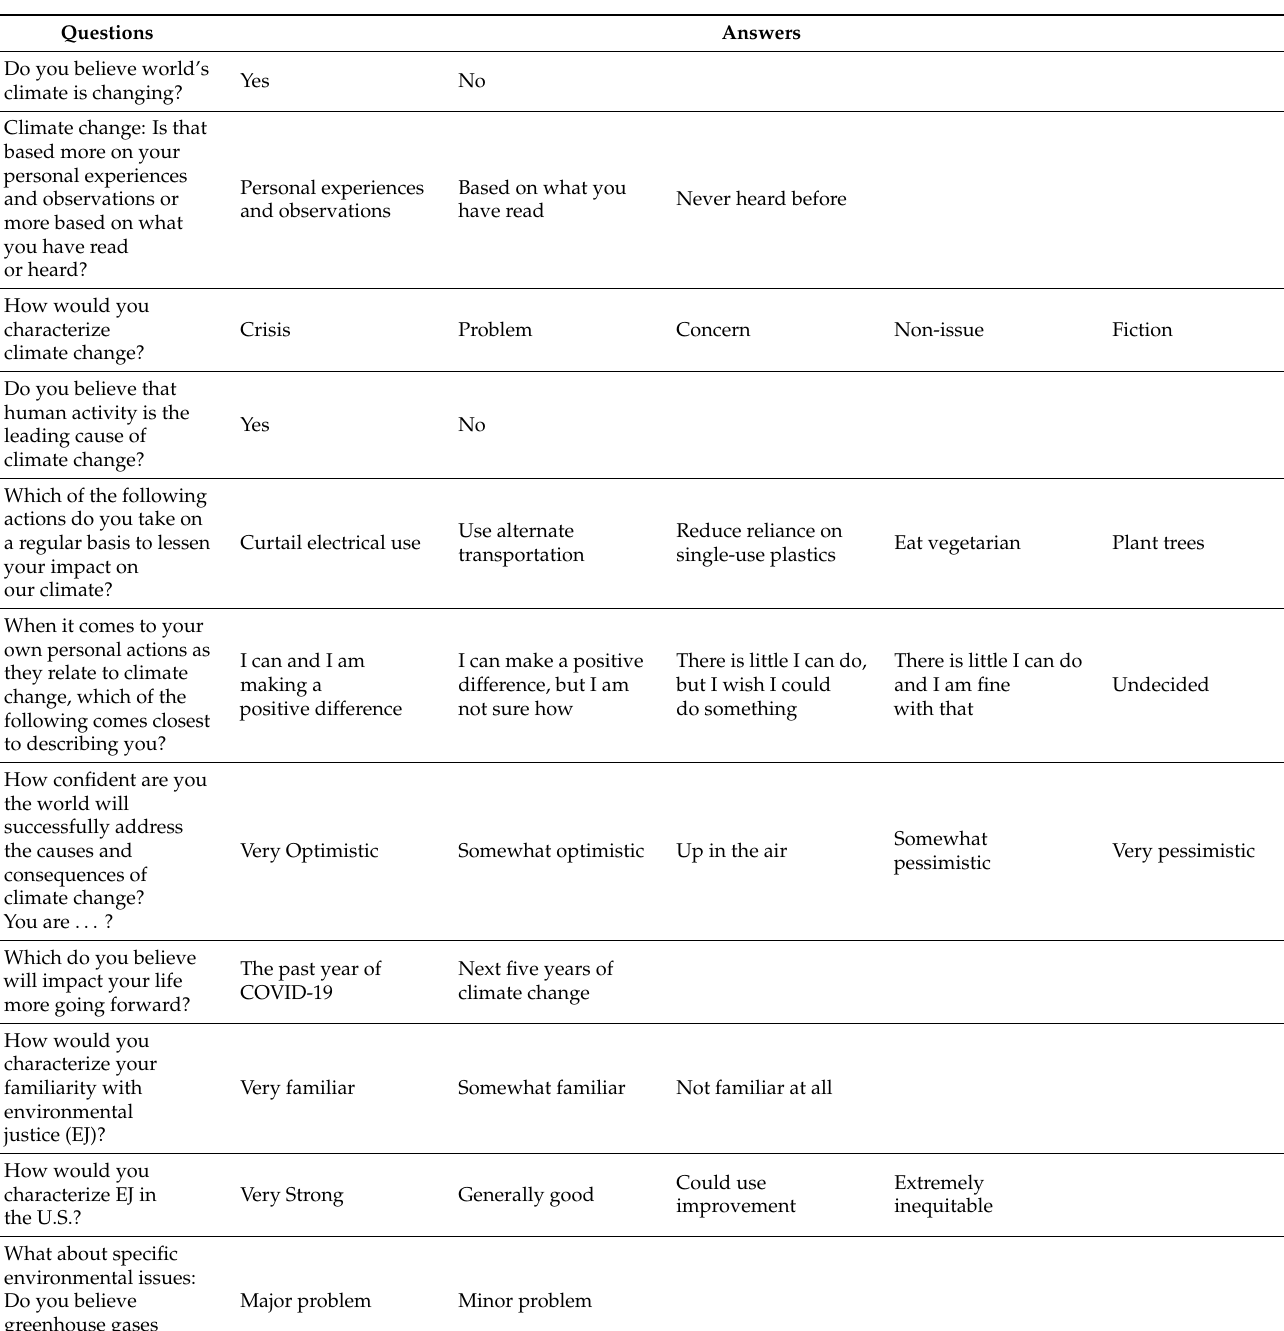
Table 1. List of questions and answers, “Climate Change Awareness Survey”, adapted by the